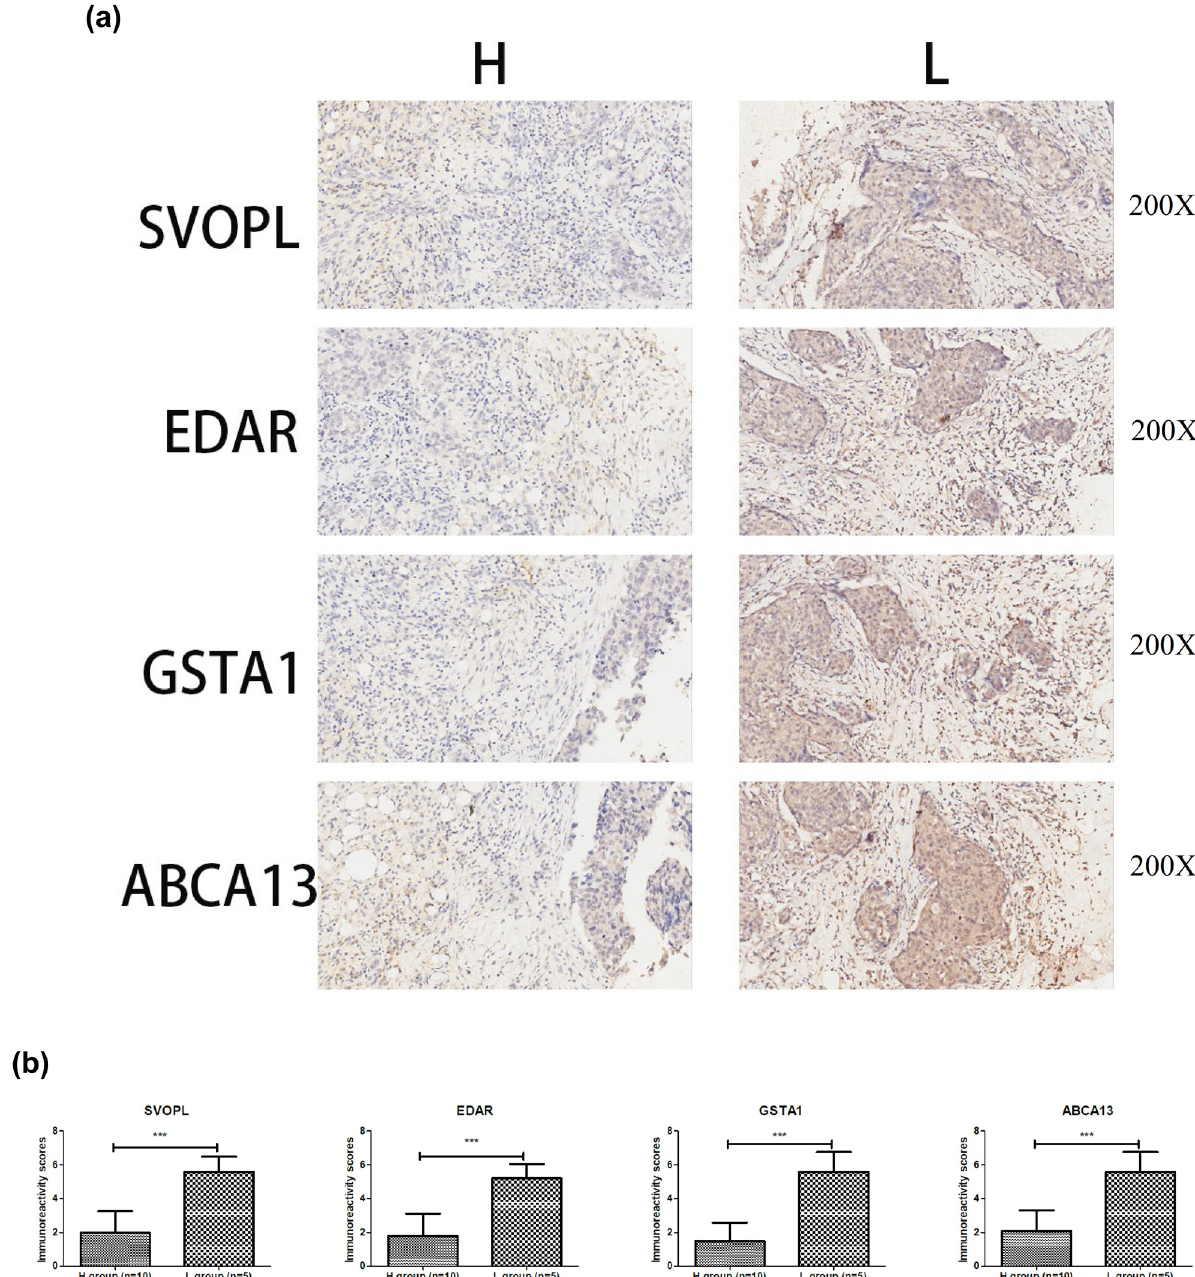
Figure 9: Representative immunohistochemistry images of ABCA13, EDAR, GSTA1, and SVOPL in H and L groups ( a ) . The immunoreacivity scores of ABCA13, EDAR, GSTA1, and SVOPL in H and L groups ( b ) . *** p <